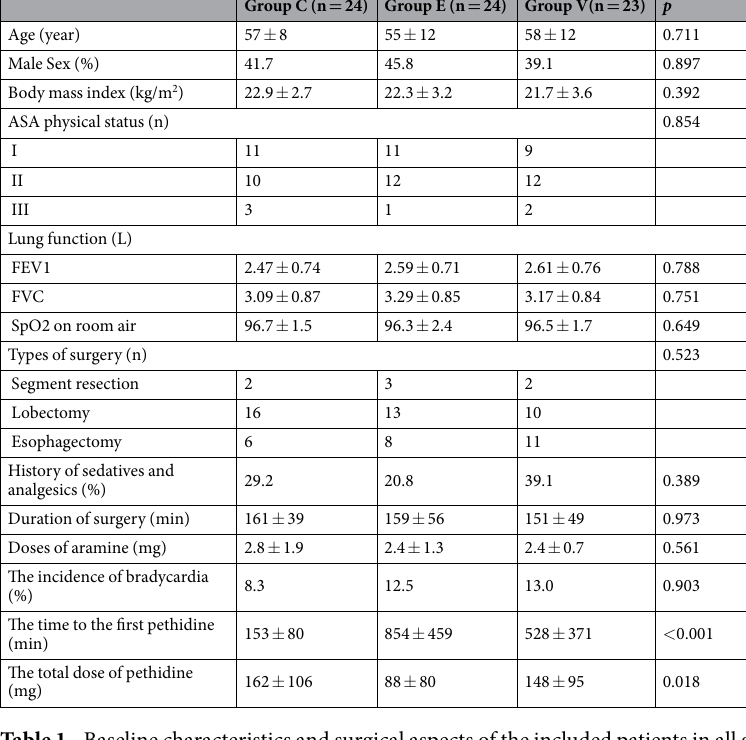
Table 1. Baseline characteristics and surgical aspects of the included patients in all groups.